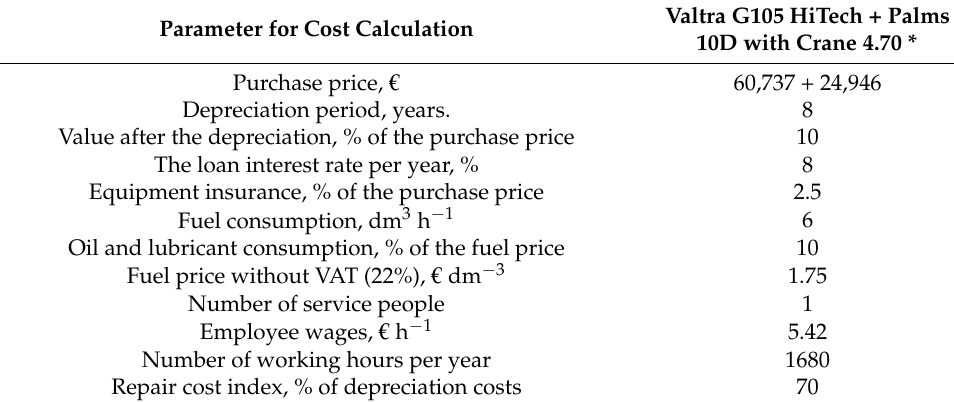
Table 2. Input data for the calculation of the cost of short wood forwarding.